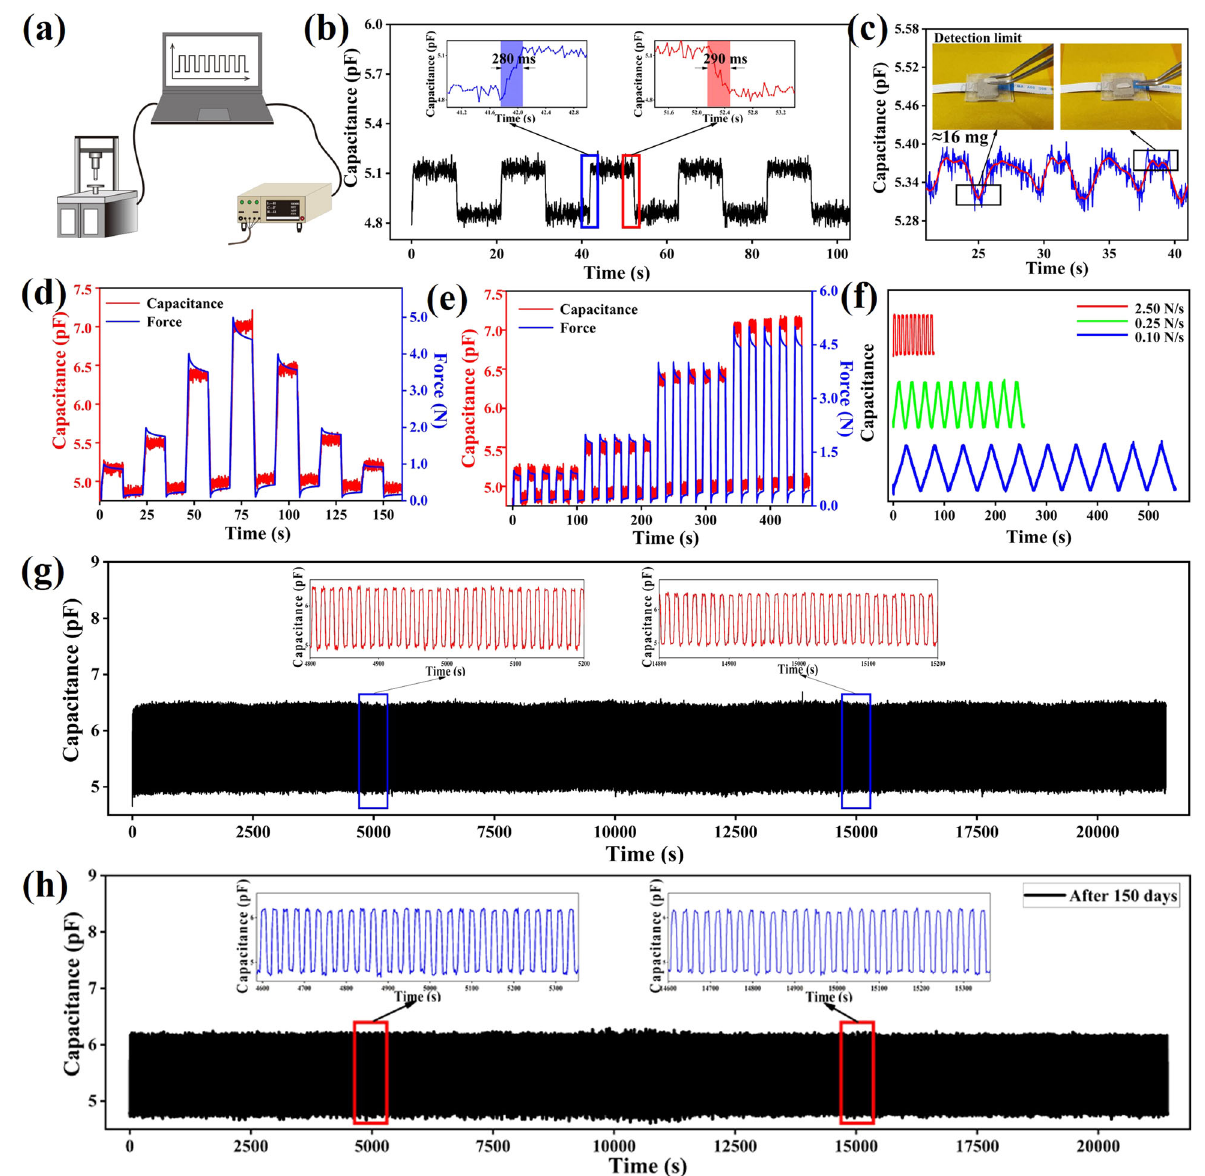
Fig. 4 Electron-mechanical characteristics of the fl exible capacitance sensor. a Schematic diagram of the testing platform; b Response time of the sensor with the insets corresponding to the loading and unloading process; c Detection limit test by loading/unloading a grain of rice with a weight of 16 mg; d Capacitance change with the gradient increase and decrease under 10 – 45 kPa; e Cyclic capacitance changes under 10 – 45 kPa at the same frequency; f Ten cycles of the sensor with different loading speeds; g , h Stability test of the sensor under 40 kPa before and after 150 days; the insets are partially magni fi ed curves for different cycle